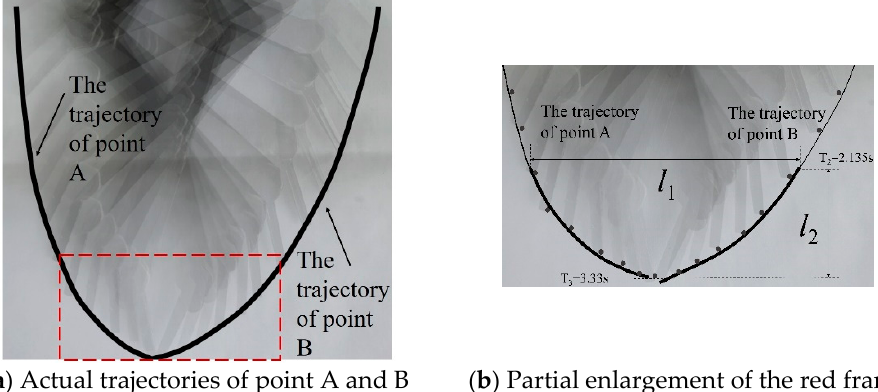
Figure 16. Components of the pick-up device.